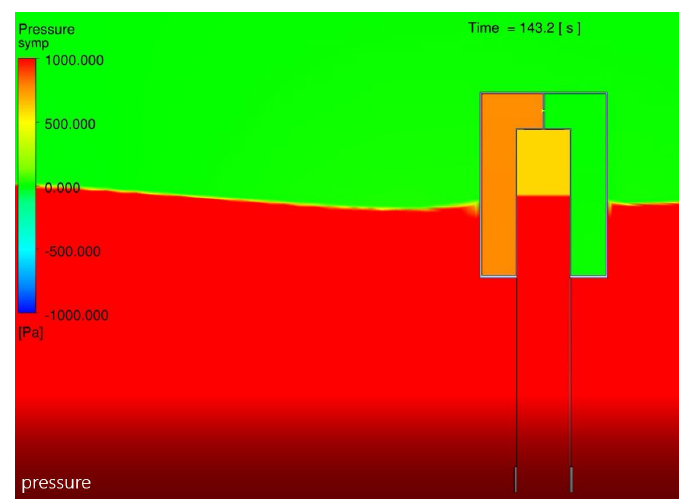
Figure 7. 2D picture of the full-scale Tupperwave device in two-meter high regular waves of 8-s periods.